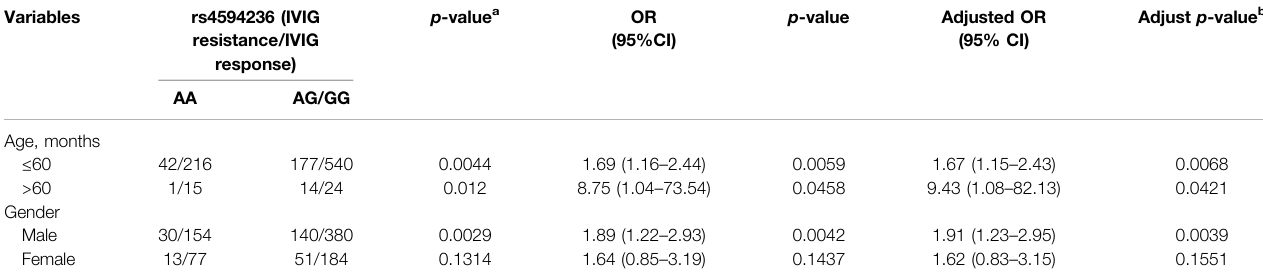
TABLE 5 | Strati fi cation analysis of EIF2AK4 /rs4594236 polymorphism in the IVIG therapy resistant group and response group of KD patients. Variables rs4594236 (IVIG